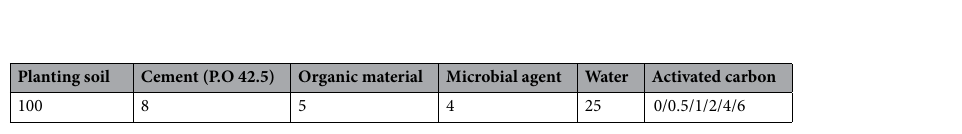
Figure 1. SEM images of the wood activated carbon ( A ) and mineral activated carbon ( B ) used in the experiment.